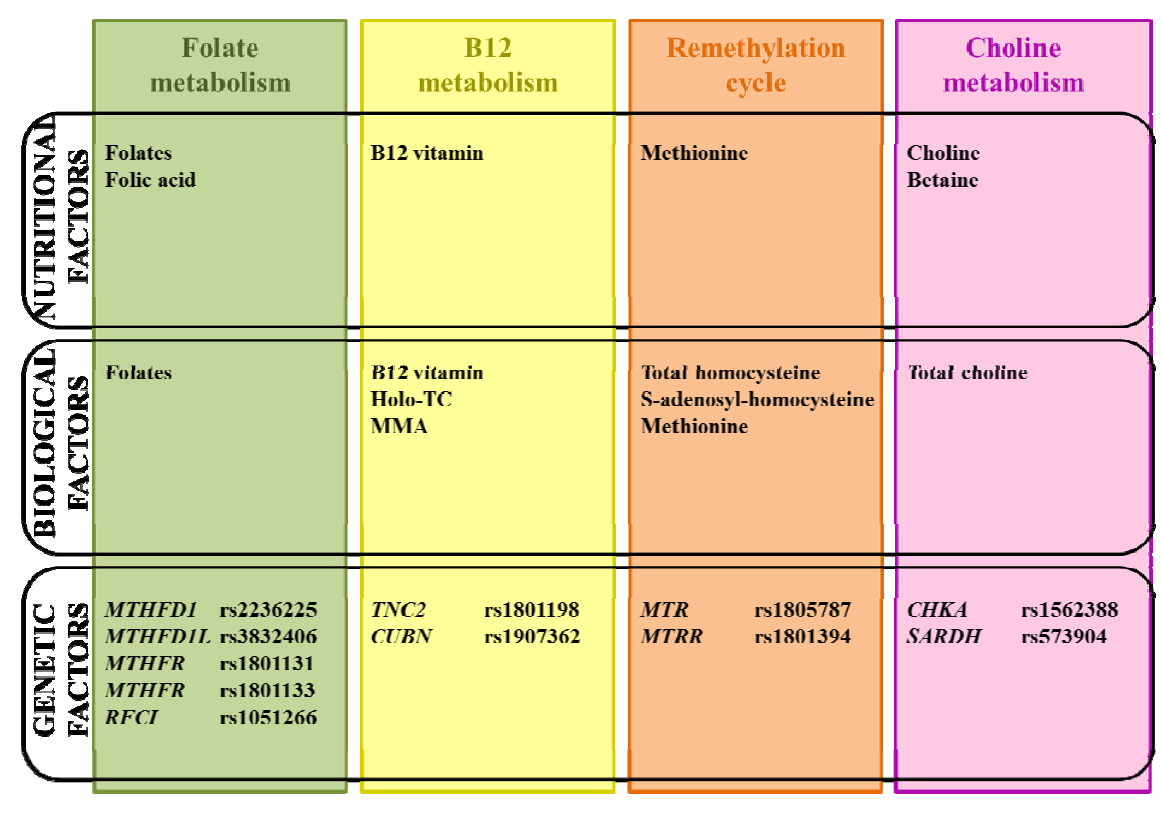
Figure 4. Nutritional, biological, and genetic risk factors of folate, B12 vitamin, remethylation and choline metabolisms that have (potentially) been related with NTDs risk. MMA: Methylmalonic acid, holo-TC: